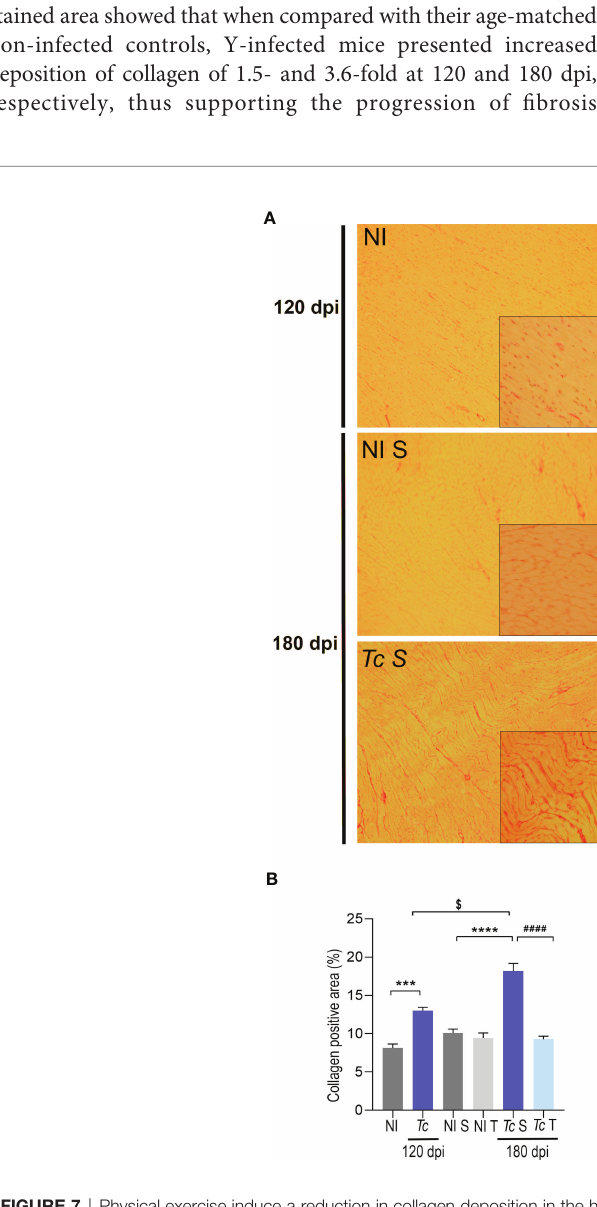
FIGURE 7 | Physical exercise induce a reduction in collagen deposition in the hearts of C57BL/6-infected mice. (A) Representative sections stained with Picrosirius red. Black arrows indicate positive staining for Picrosirius red . (B) Densitometric analysis of Picrosirius red staining. (C) Correlations of the QTc interval and collagen deposition. The data are represented as means ± SEM. Data represent six to eight mice per group. Signi fi cant differences between infected and uninfected groups. ***p < 0.001 and ****p < 0.0001; signi fi cant differences between the untrained and trained groups, #### p < 0.0001; signi fi cant differences comparing infected groups at 120 dpi and 180 dpi $ p < 0.0001 (Mann – Whitney; two-way ANOVA, Sidak ’ s posttest; Kruskal – Wallis test, Dunn ’ s posttest ).